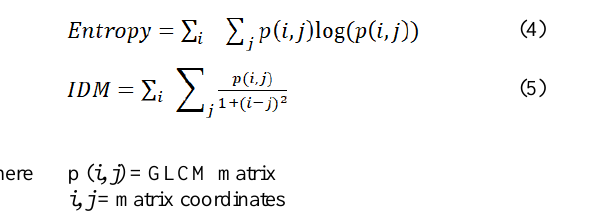
Figure 2. Features comparison of different residential types calculated based on